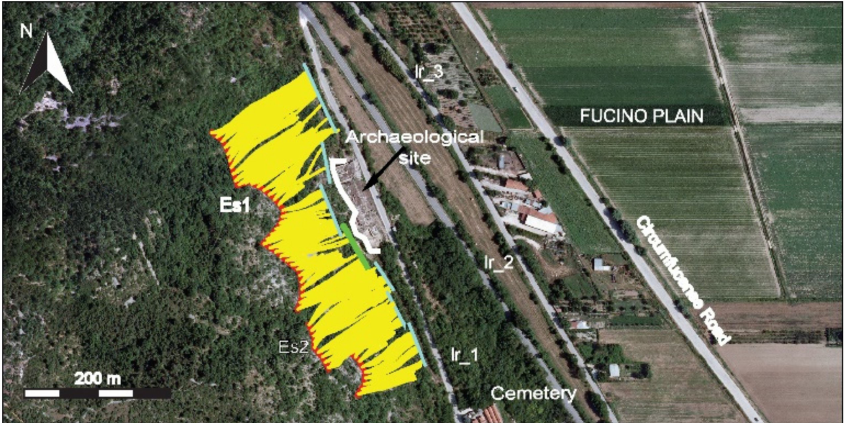
Figure 15. Mitigation measures designed after modelling results which include the installation of further barriers along the slope (thin, light blue lines).